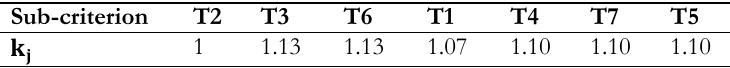
Table 9. 𝐤 𝐣 Growth values for each sub-criterion.